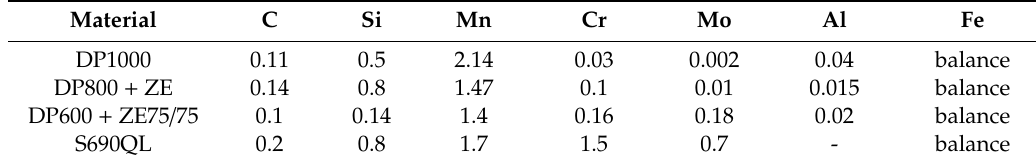
Table 2. Welding parameters for the RSW.